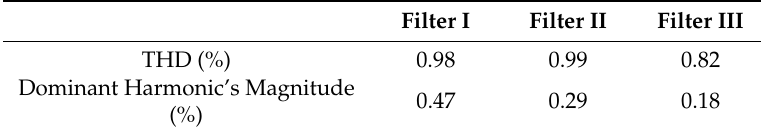
Table 5. Percent Total Harmonic Distortion (THD)and dominant harmonic’s magnitude in Filter I Filter II Filter III THD (%) 0.98 Dominant Harmonic’s Magnitude (%) Filter I Filter II Filter III THD (%) Dominant Harmonic’s Magnitude